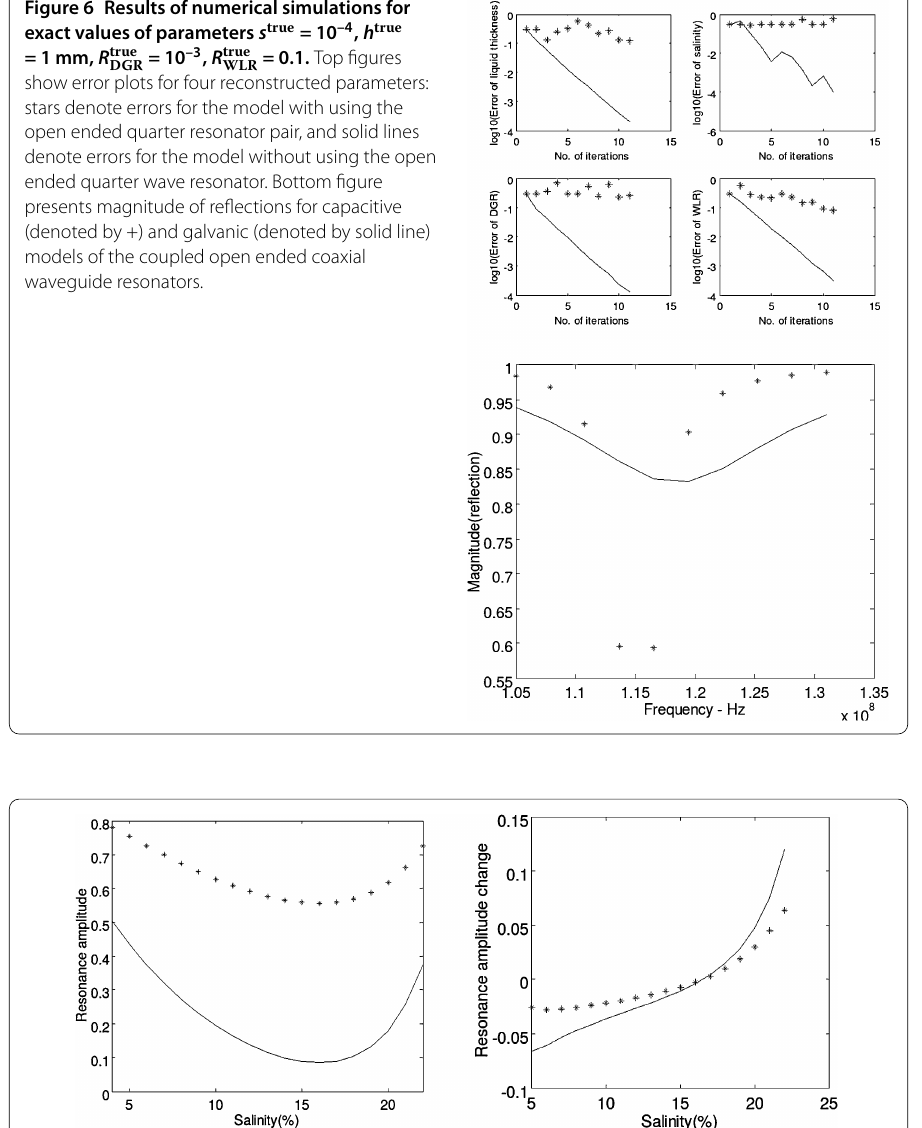
Figure 7 Behavior of resonance amplitude versus salinity at lowest resonance frequency. Crosses denote results for capacitive model while solid lines-for galvanic model of the coupled open ended coaxial waveguide resonator. Results are presented for liquid thickness h = 4 mm, R WLR = 1, R DGR = 10 –5 . The resonance amplitude is shown at the left figure and change in the resonance amplitude is presented at the right